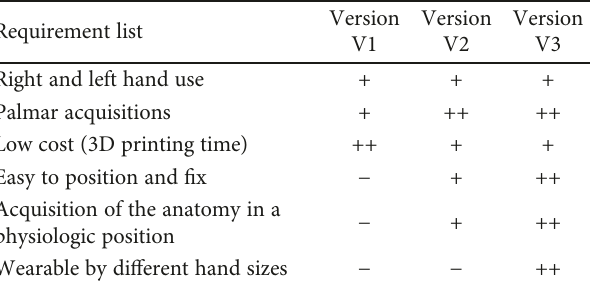
Table 3: Support version